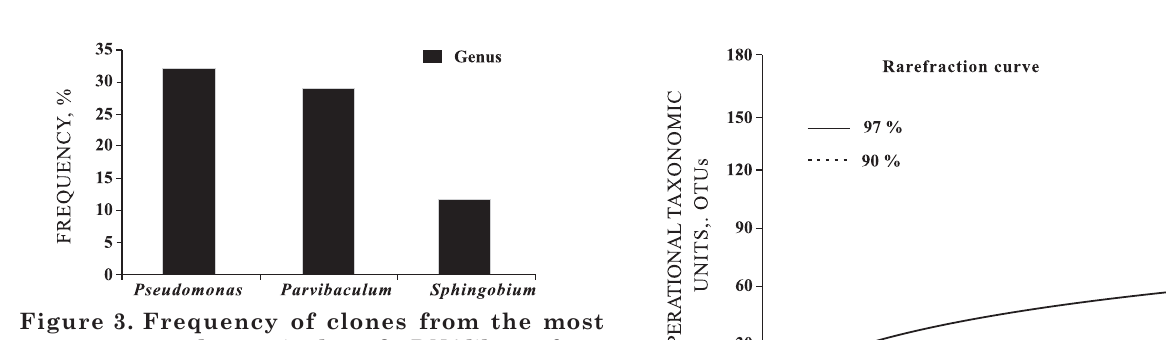
Figure 2. Phylogenetic tree based on the partial sequences of 16S rDNA from the consortium, generated by the MEGA program, version 4. The distance matrix was calculated by the “Neighbor-Joining” algorithm and the nucleotide substitution method “Kimura 2-P”, with a “bootstrap” of 1000 repetitions.